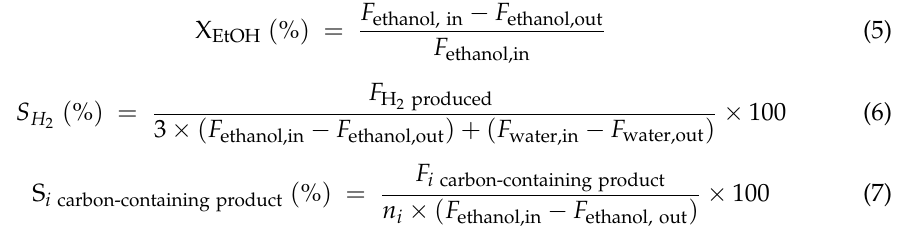
where F i , in/out is the molar flow rate of the i specie at the inlet/outlet of the reactor, respec- tively, and n i is the stoichiometric factor between the carbon-containing products and ethanol.